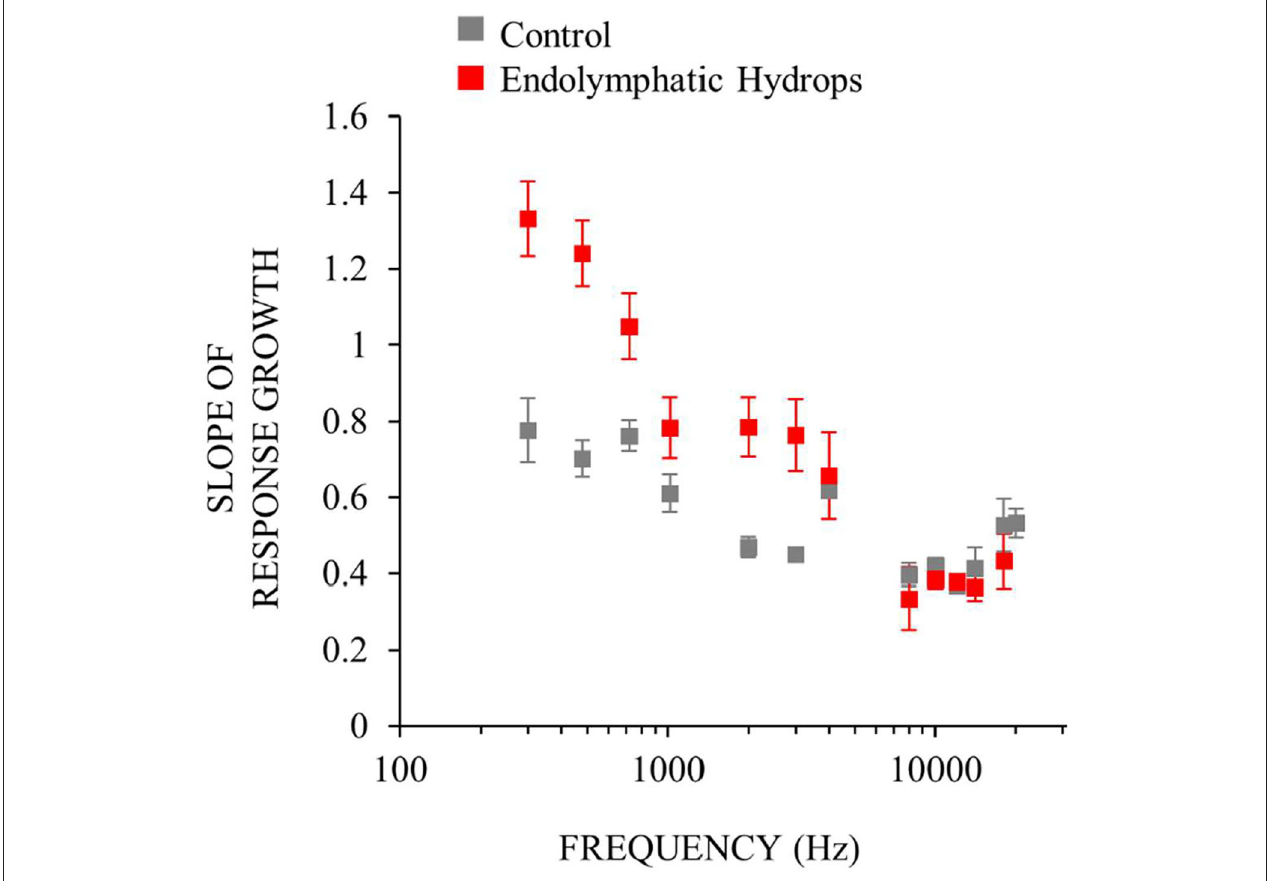
FIGURE 4 | Neural response recruitment quantified by the median slopes of response-amplitude vs. sound-level functions, vs. frequency. Points are medians. Error bars are one standard error of the mean. Data from ears with endolymphatic sac ablation are red, and from control ears are gray. Data are from the same measurements as Figure 3